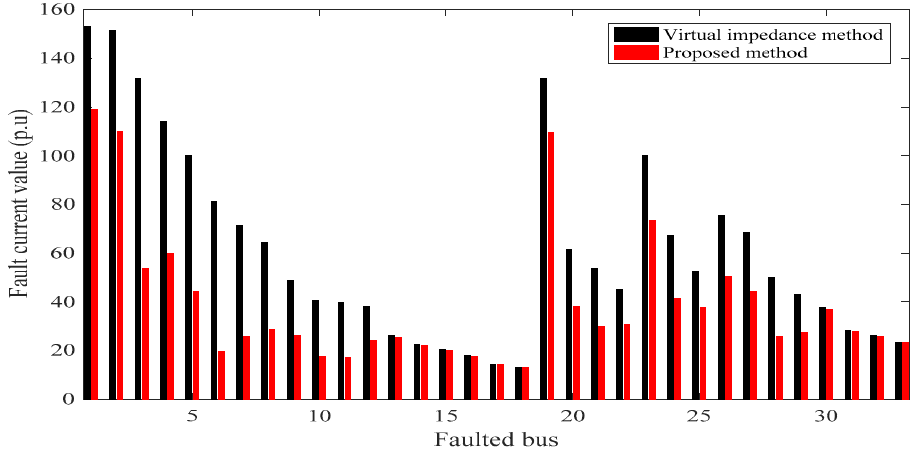
Figure 5. The value of fault current in all buses using virtual impedance and proposed methods.